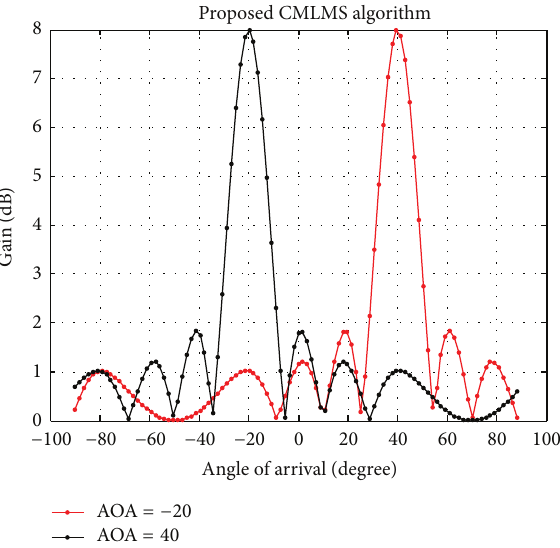
Figure 3: Beam pattern achieved by CMLMS